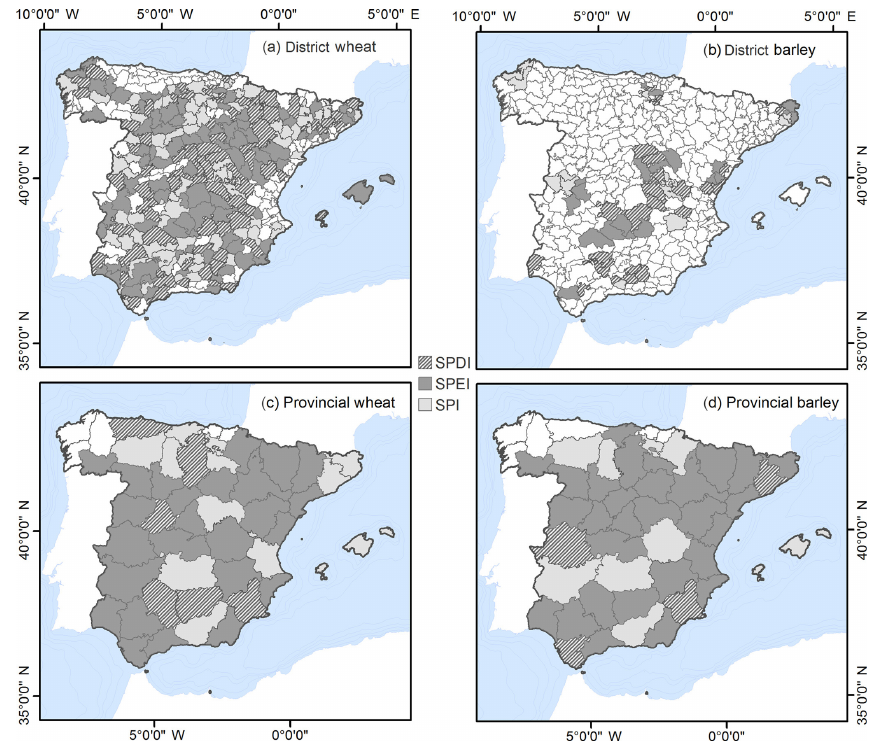
Figure 6. Spatial distribution of the drought indices with the strongest correlations with wheat (a, c) and barley (b, d) at the province (c, d) and agricultural district (a, b)